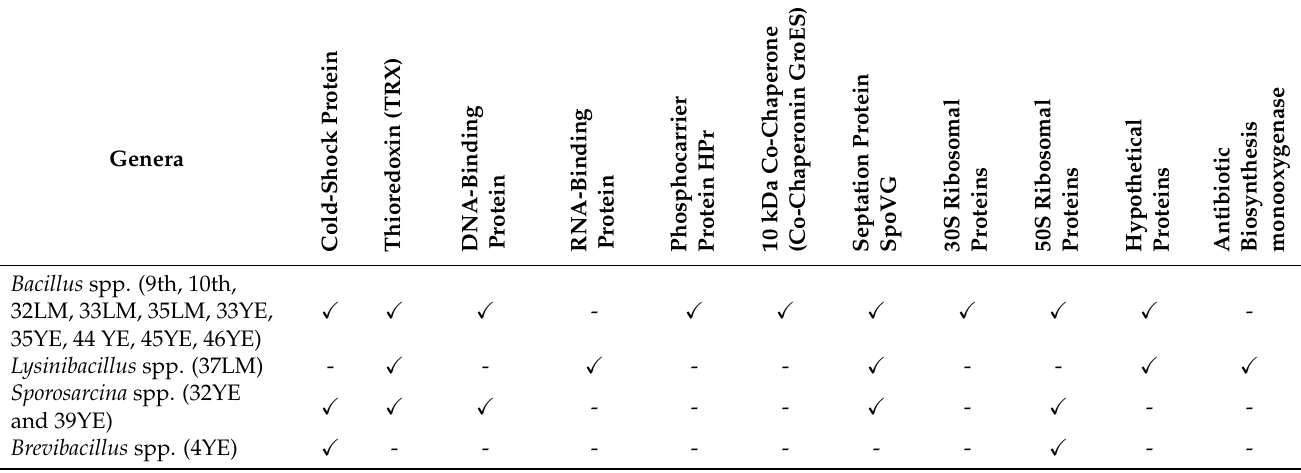
Table 2. Putative promising AMPs were identified by MS/MS for different genera (Supplementary File S2, Tables S1–S8).